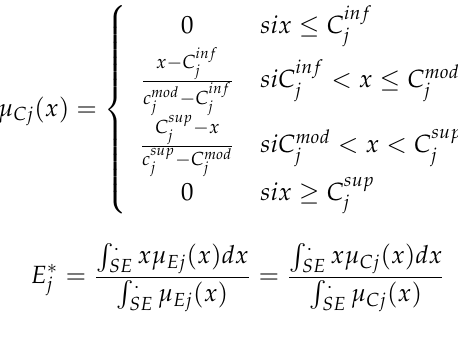
centroid method to defuzzify the fuzzy tardiness and obtain a real number where E ∗ represent the defuzzification value of earliness and tardiness of job j , x µ Ej ( x ) and x µ Tj ( x ) represent the membership function of the fuzzy earliness and